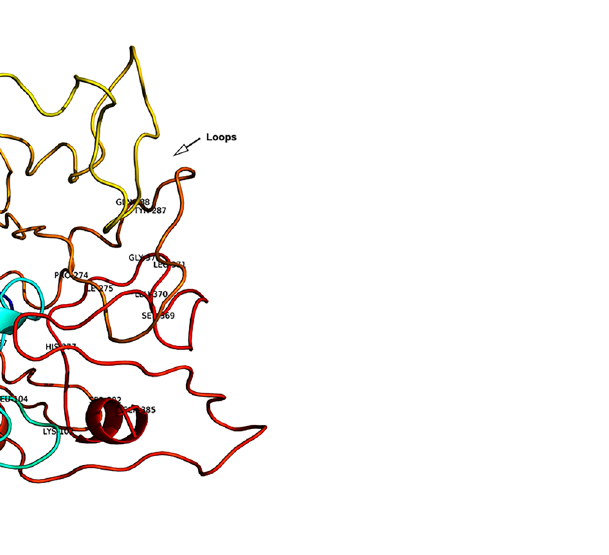
Figure 3. ( a ) Z-score and number of amino acids indicating accuracy and completeness of predicted structure ( b ) Z-Score plot of model predicted by I-Tasser with structures available in database ( c ), Energy plot for amino acid residues for the 3D-structure of I-Tasser.